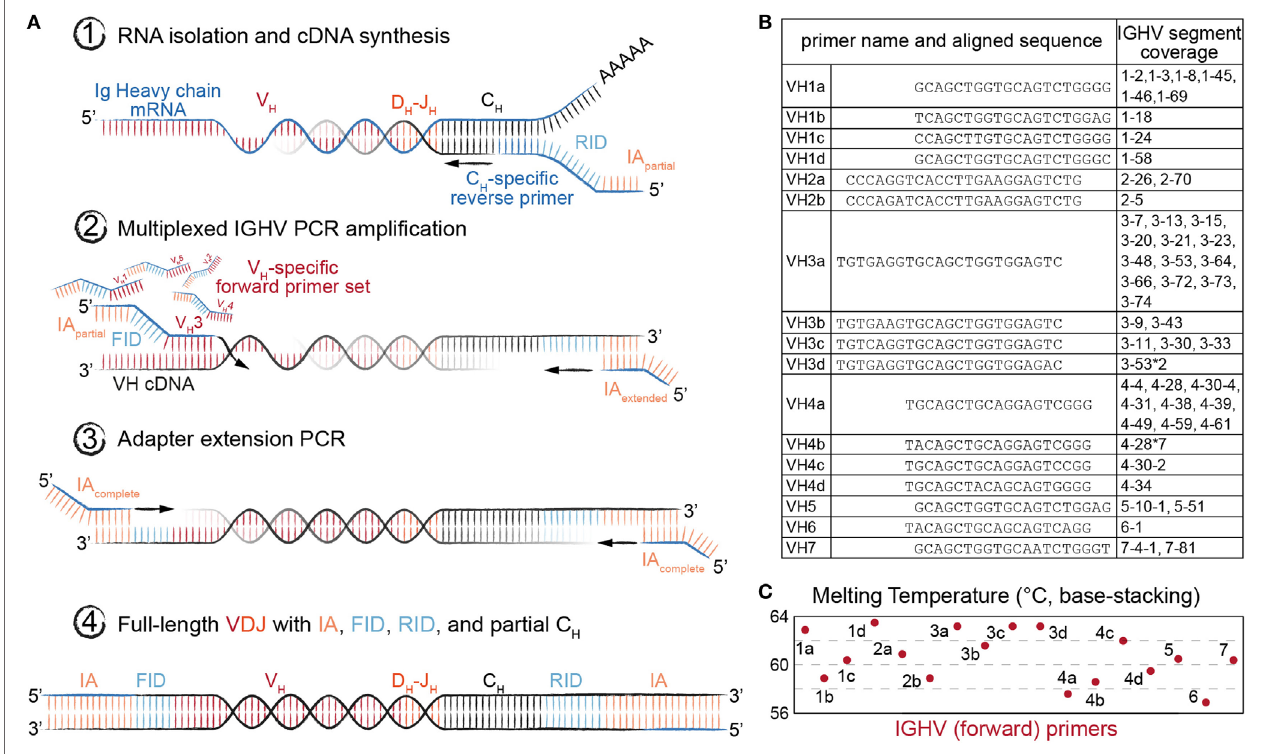
FIgURe 2 | Library preparation of immunoglobulin (Ig) heavy-chain genes for high-throughput sequencing (Ig-seq) using molecular amplification fingerprinting (MAF). (A) In step 1, reverse transcription (RT) is performed to generate first-strand cDNA with a gene-specific (IgM or IgG) primer, which includes a unique reverse molecular identifier (RID) and partial Illumina adapter (IA) region. This results in single-molecule labeling of each cDNA with an RID. In step 2, several cycles of multiplex-PCR are performed using a forward primer set with gene-specific regions targeting heavy-chain variable (V H ) framework region 1 (FR1), with overhang regions comprised of a forward unique molecular identifier (FID) and partial IA. In step 3, singleplex-PCR is used to extend the partial IAs. The result (Step 4) is the generation of antibody amplicons with FID, RIDs, and full IA ready for Ig-seq and subsequent MAF-based error and bias correction. (B) List of oligonucleotides sequences annealing to the V H FR1 used in multiplex-PCR (Step 2) of the MAF library preparation protocol. The nearest germline IGHV segment(s) likely to be amplified by the respective primer are listed in the rightmost column. (c) The estimated melting temperature distribution of the V H FR1 forward primer